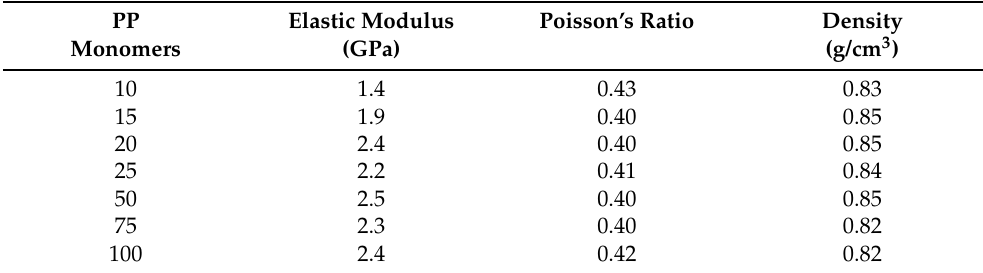
Table 1. Elastic properties for pure PP systems with a different number of monomers in the polymer chain. The simulation cell size was 10 × 10 × 10 nm 3